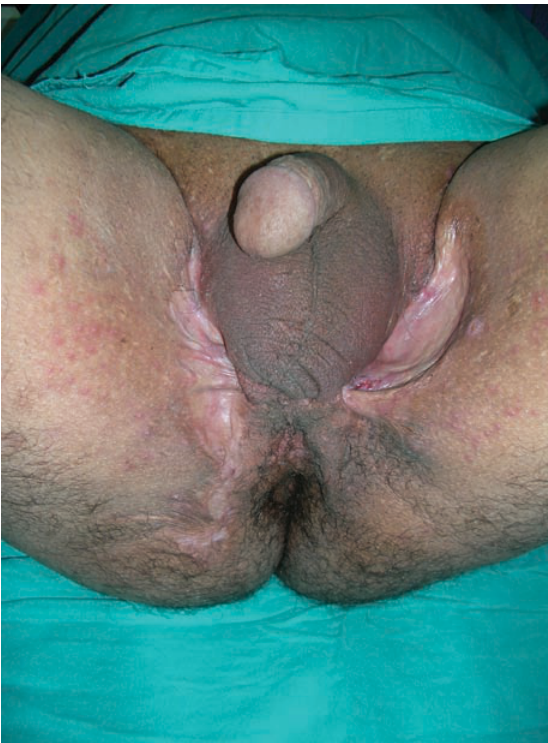
Figure 4. A well healed hidradenitis suppurativa in the groin area. Figure 5. Long term result of an axillary hidradenitis suppurativa